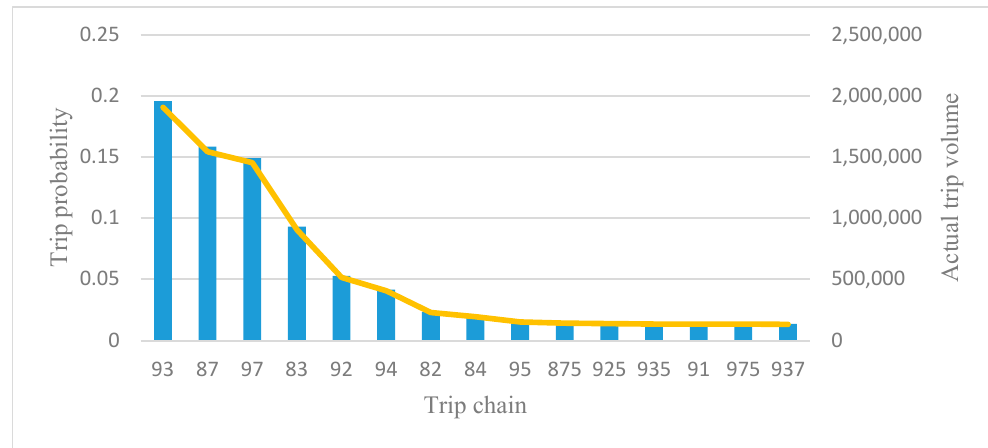
Figure 7. The distribution of the trip probability of the first 15 trip chains.